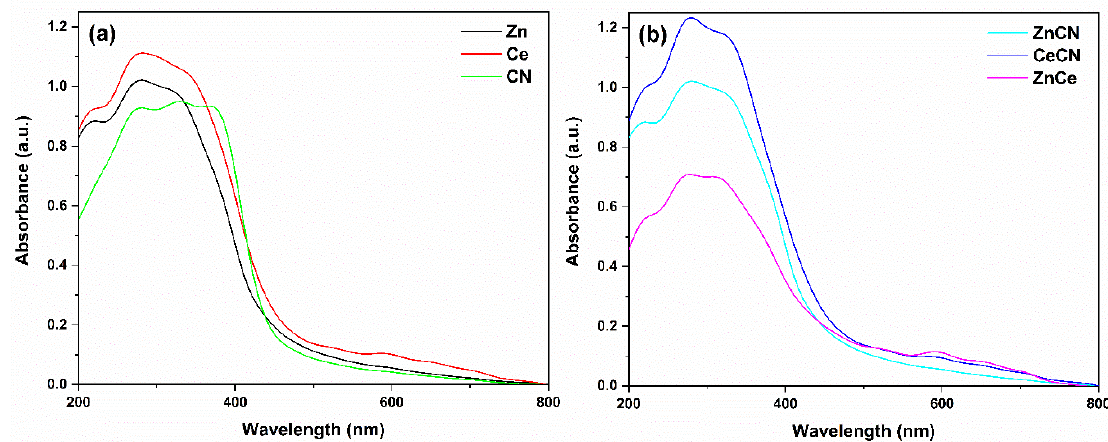
Figure 5. Absorption spectra of ( a ) pure and ( b ) binary samples.